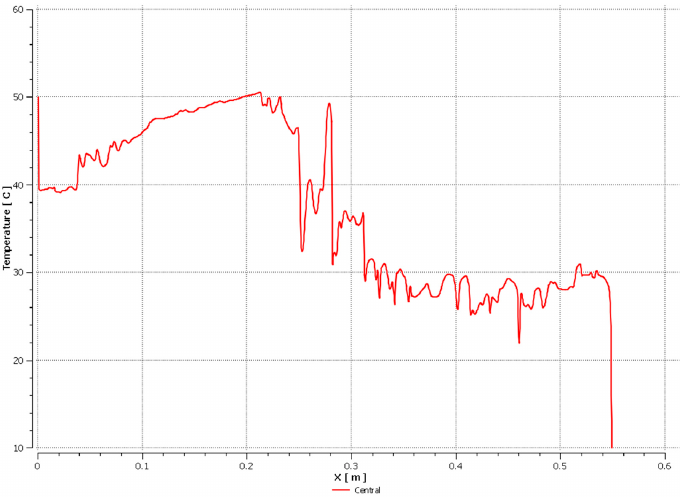
Figure 29. Temperature distribution along the height of the heat pipe’s central line.